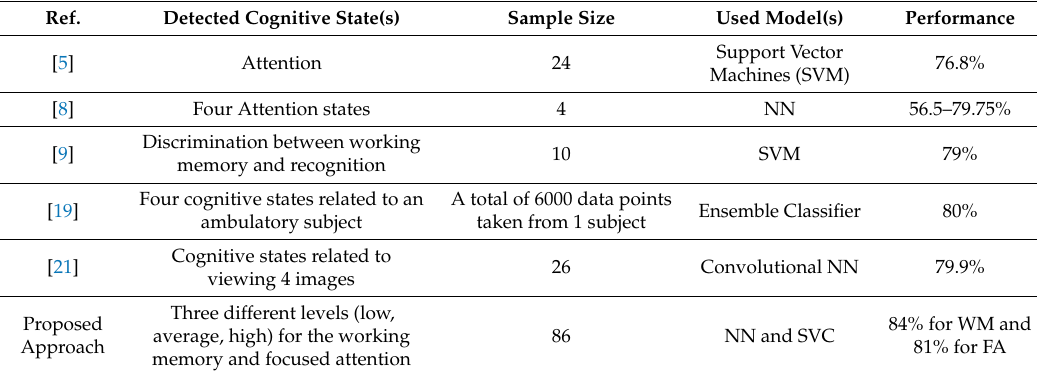
Table 3. The proposed approach in comparison with related